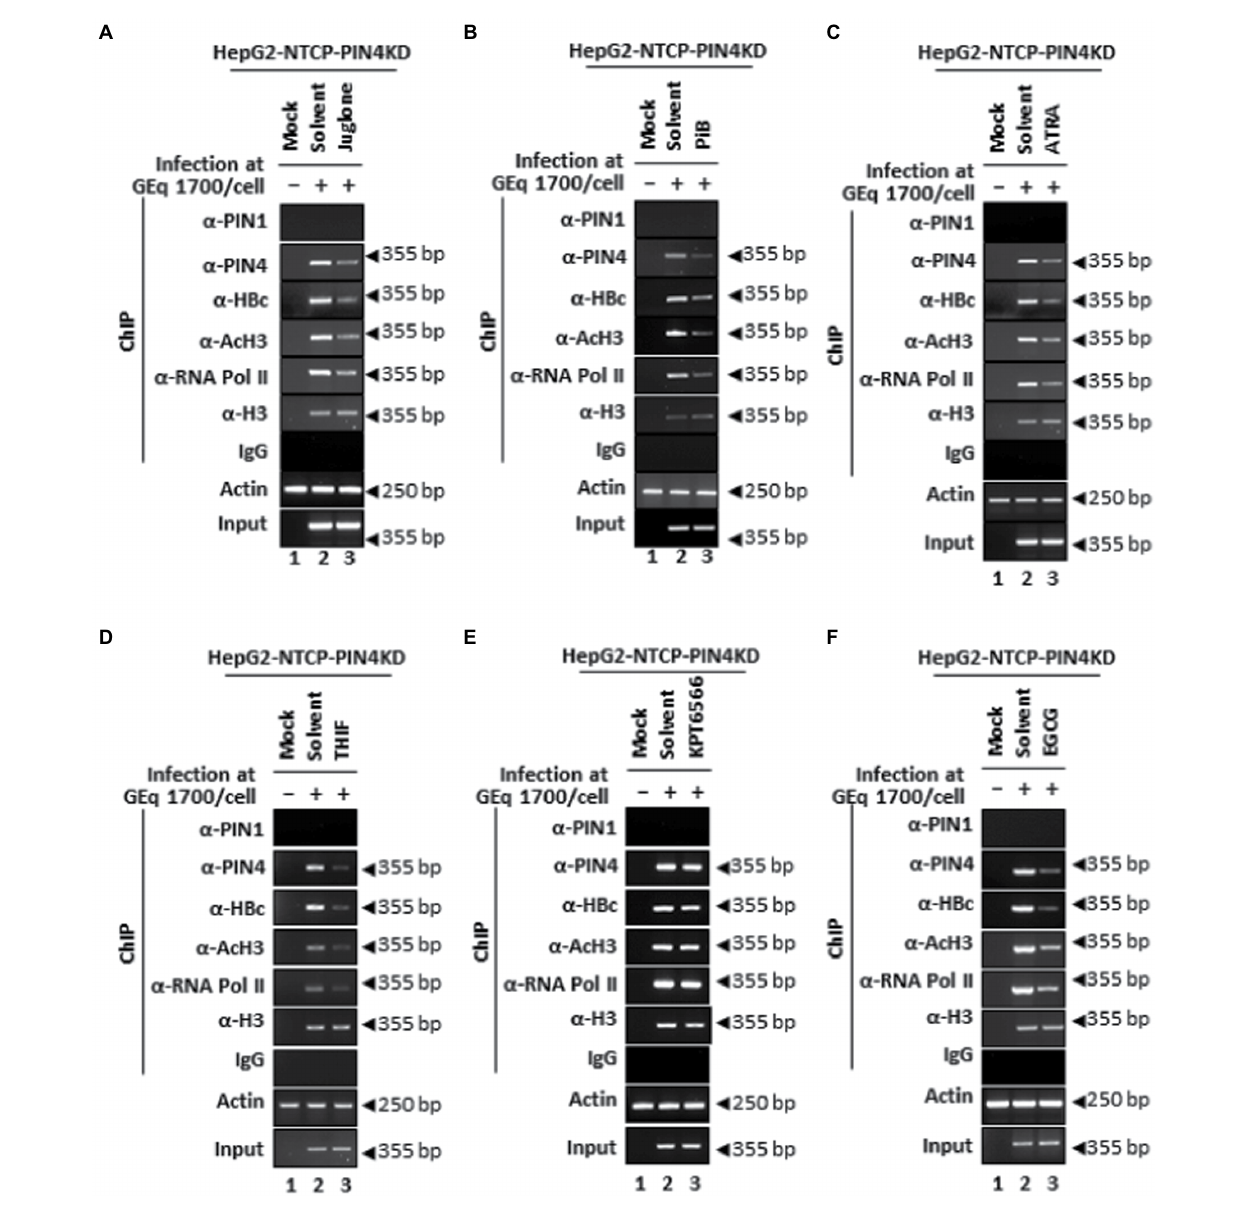
FIGURE 12 PIN4 KD followed by Juglone, PiB, ATRA, 6,7,4 ′ -THIF, KPT6566, and EGCG treatment significantly reduced HBc recruitment to cccDNA and HBV transcriptional activities in HBV-infected cells. (A–F) HepG2-hNTCP-C9-PIN4 KD cells were mock-infected (lane 1) or HBV infected (lanes 2–3) and treated with solvent (lane 2), or parvulin inhibitors (A) 20 μ M Juglone, (B) 20 μ M PiB, (C) 30 μ M ATRA, (D) 30 μ M 6,7,4 ′ -THIF, (E) 30 μ M KPT6566, and (F) 40 μ M EGCG. The chromatin solutions and ChIP were performed in HBV-infected HepG2-hNTCP-C9-PIN4 KD cells, as described in the “Material and Methods” section and were subjected to immunoprecipitation with normal rabbit polyclonal IgG, anti-PIN1, anti-PIN4, anti-RNA Pol II, anti-acetyl H3, or anti-H3 antibodies. The immunoprecipitated chromatins were analyzed by PCR. The presented data are representative of three independent